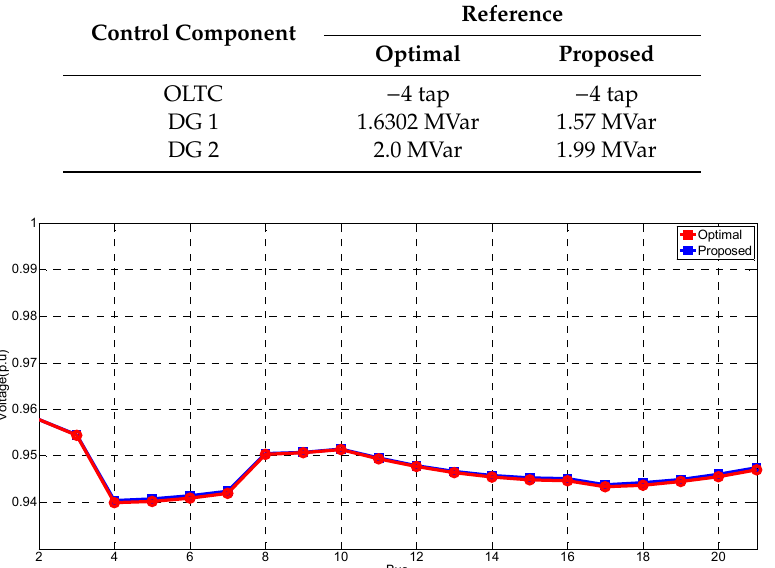
Figure 22. Comparison of optimal and proposed voltage profile for CVR in case 2.